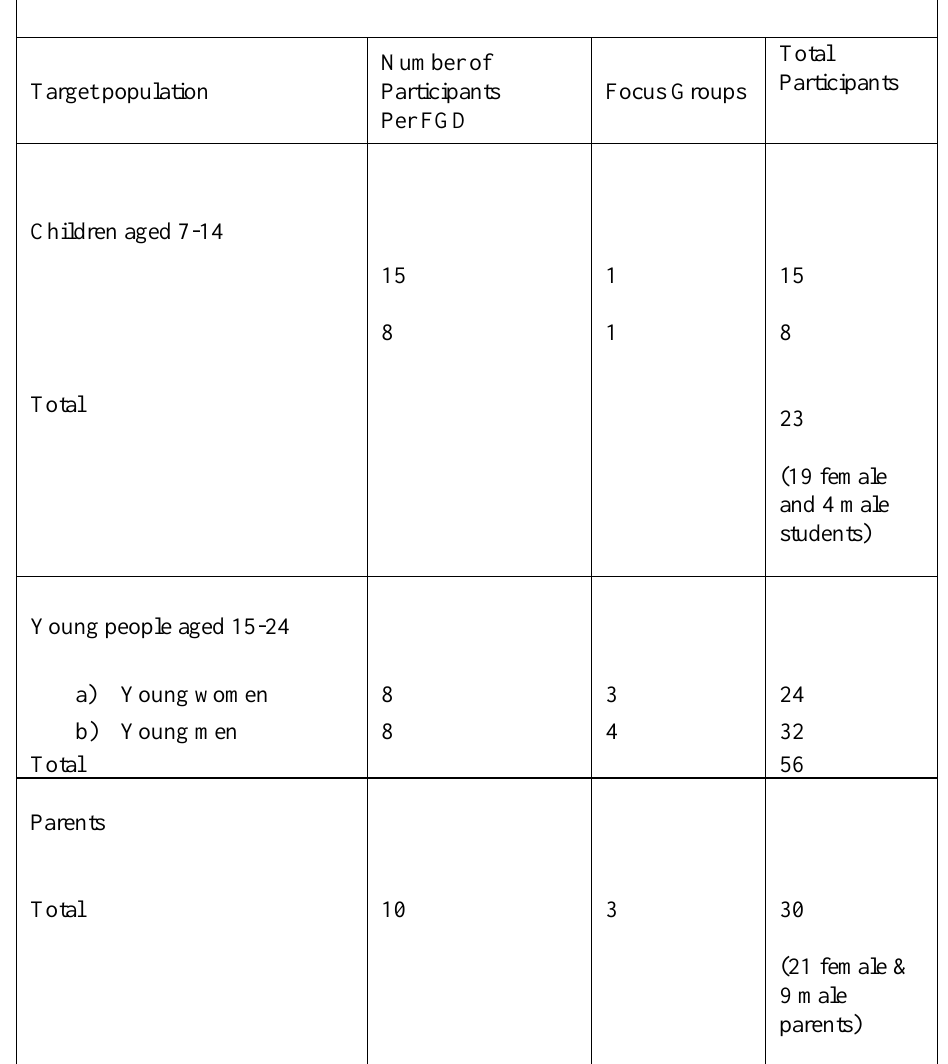
Table 1. Number of FGDs and participants per different target group